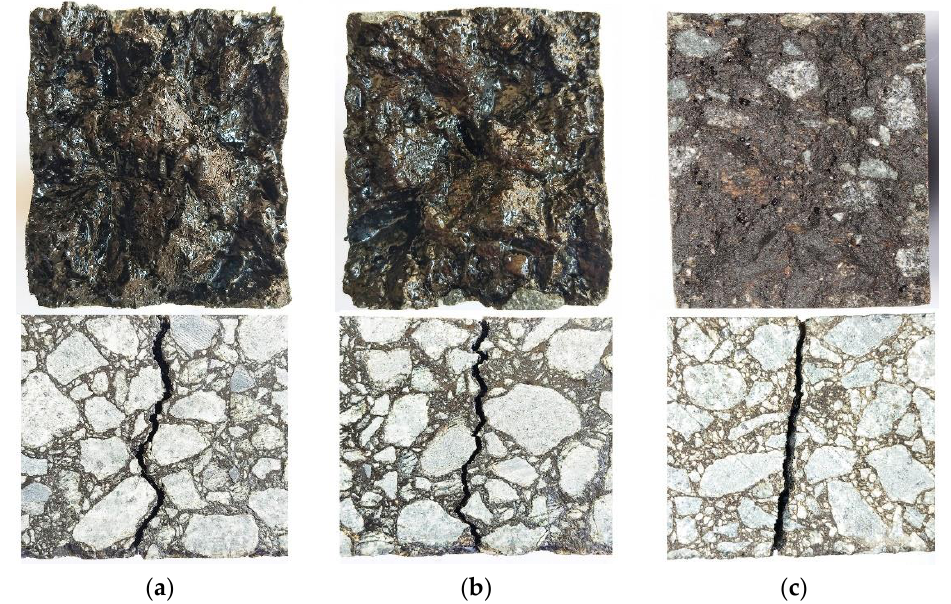
Figure 9. Beam fracture sections of different types of asphalt mixtures: ( a ) A-70, ( b ) SBS-modified asphalt, and ( c ) epoxy asphalt.